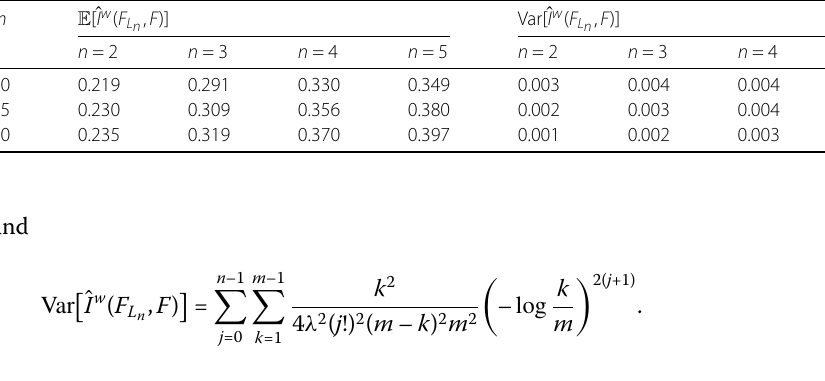
Table 2 Numerical values of E [ ˆ I w ( F L